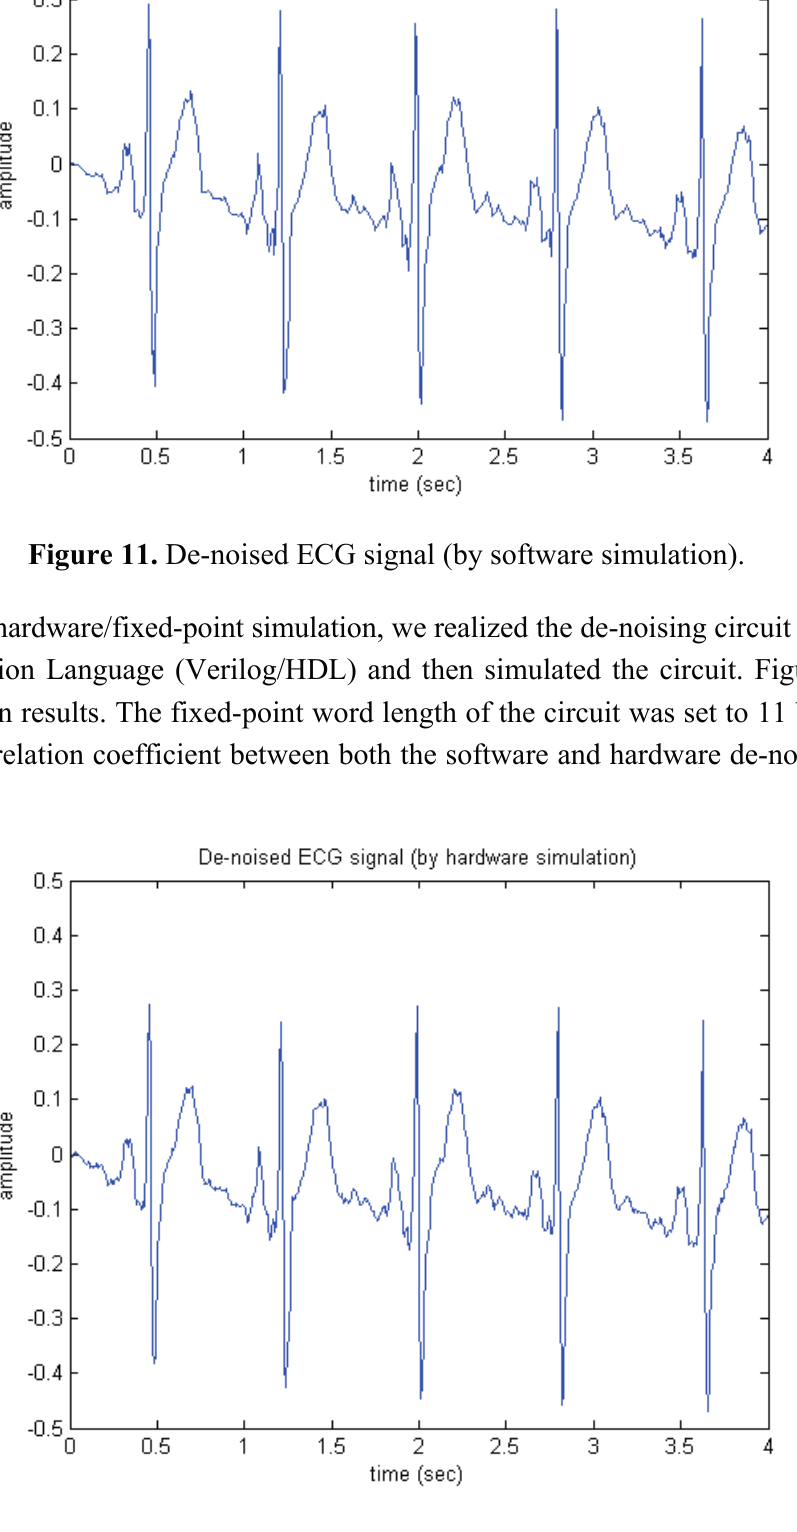
Figure 12. De-noised ECG signal (by hardware